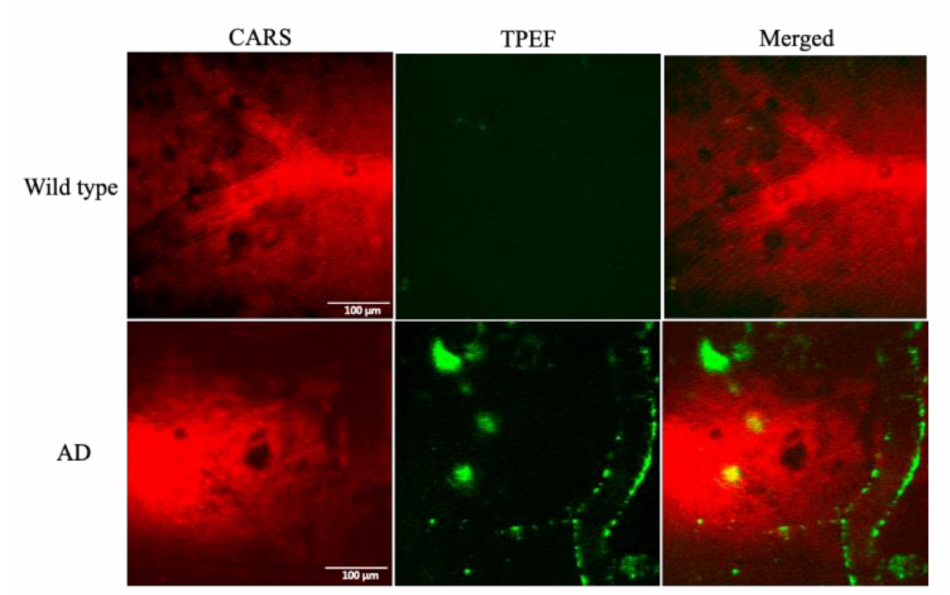
Figure 3. TPEF/CARS images of A β in the brain of Alzheimer’s disease (AD) mouse model: ( left ) CARS images at 2885 cm − 1 ; ( middle ) 800 nm excitation TPEF images; ( right ) merged images. Scale bar: 100 µ